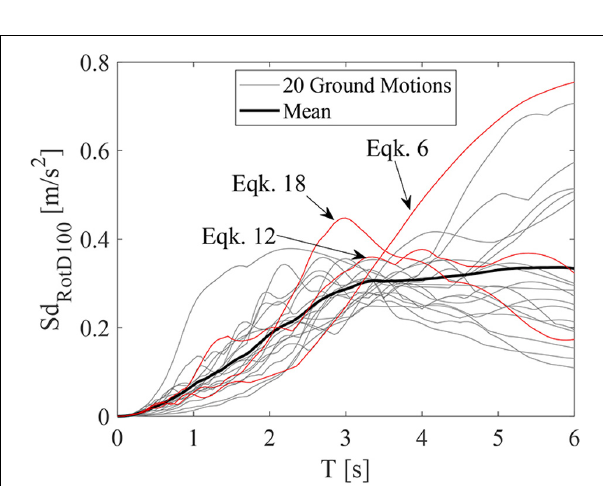
FIGURE 10 | Displacement spectra in terms of RotD100 of the selected set of records for T R = 10000